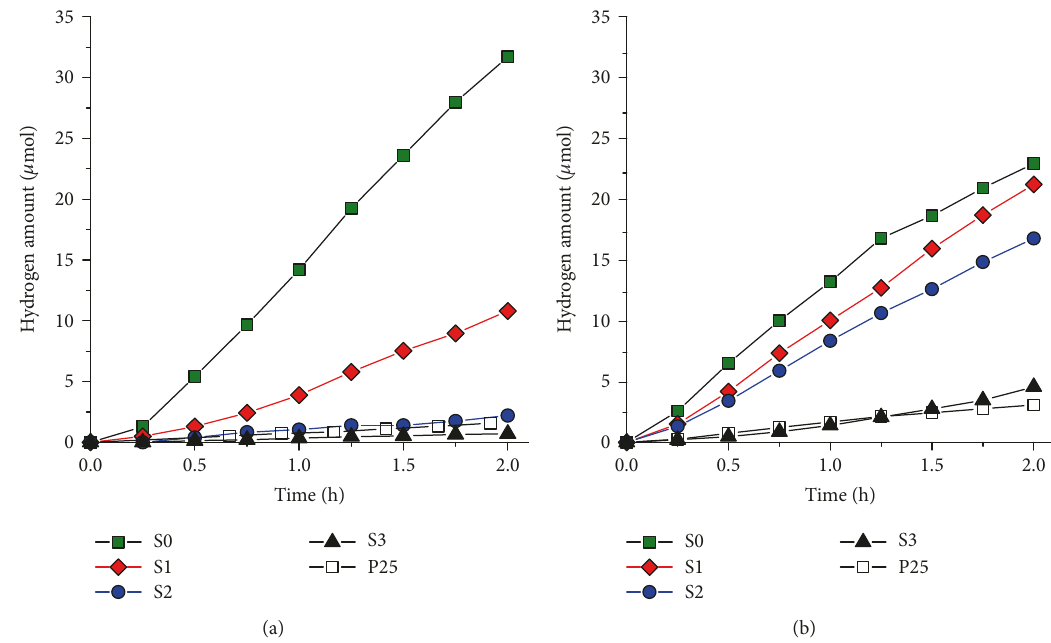
La Ti O samples S0, S1, S2, S3, and TiO 2 2 3 10